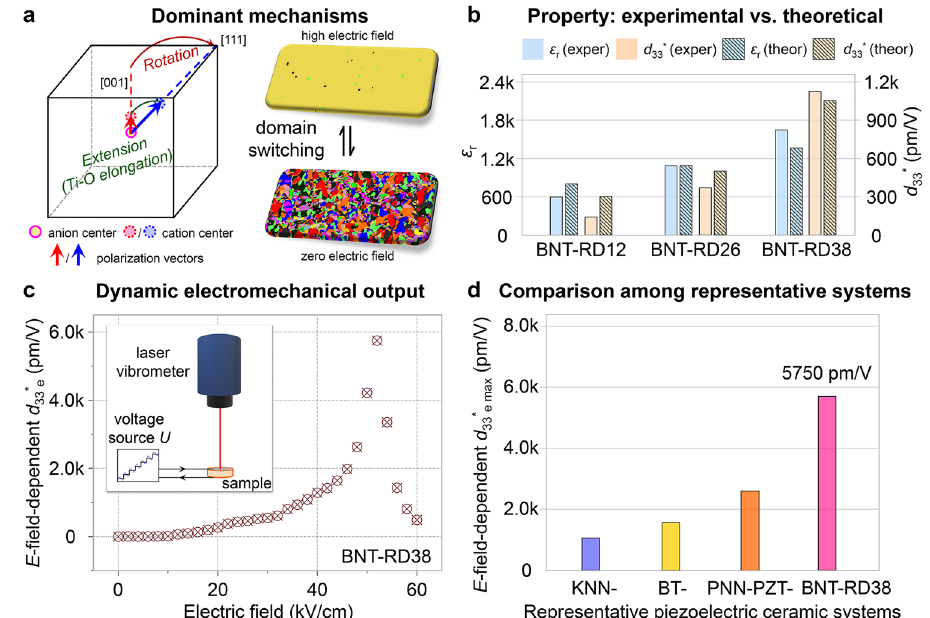
c Dynamic electromechanical output re fl ected by the E - fi eld-dependent effective piezoelectric strain coef fi cient d 33 * e . The inset shows the schematic illustration of how to measure the E - fi eld-dependent d 33 * e , see details in Supplementary Infor- mation 1.2. d Comparison of the maximum of E - fi eld-dependent d 33 * e in repre- sentative electromechanical ceramic systems. Details can be seen in Supplementary Fig.